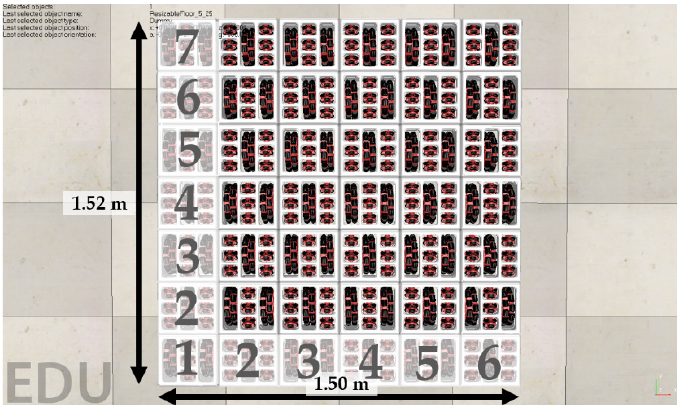
Figure 6. A top view screenshot of the proposed E-pattern omniwheeled cellular conveyor (EOCC) platform in V-REP environment.